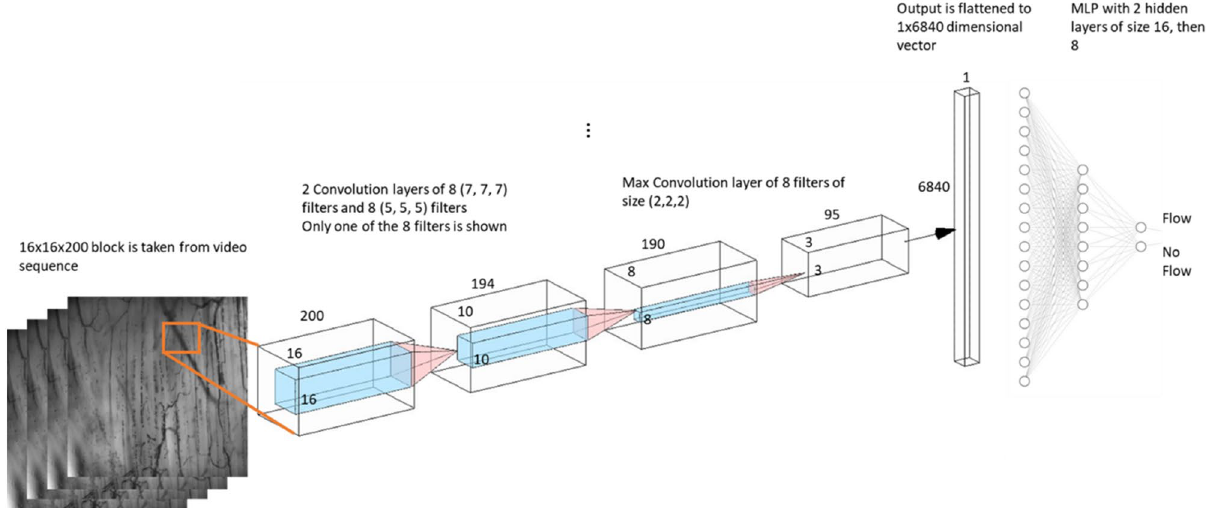
Figure 7. Visual representation of 3D-CNN architecture. The data is processed through a series of convolution layers, ultimately resulting in a flow or no-flow status in a particular vessel segment (image produced by author O. Mahmoud)